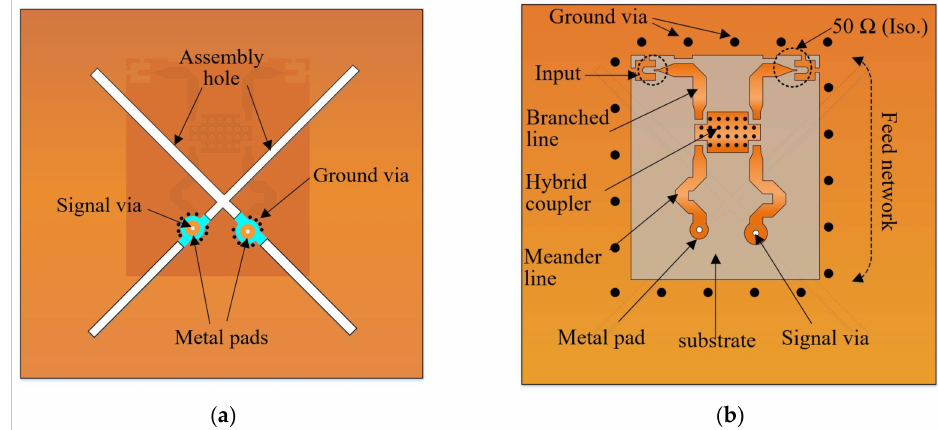
Figure 4. Geometry of the dual-layer printed reflector showing the feed network; ( a ) Top view; ( b ) Back